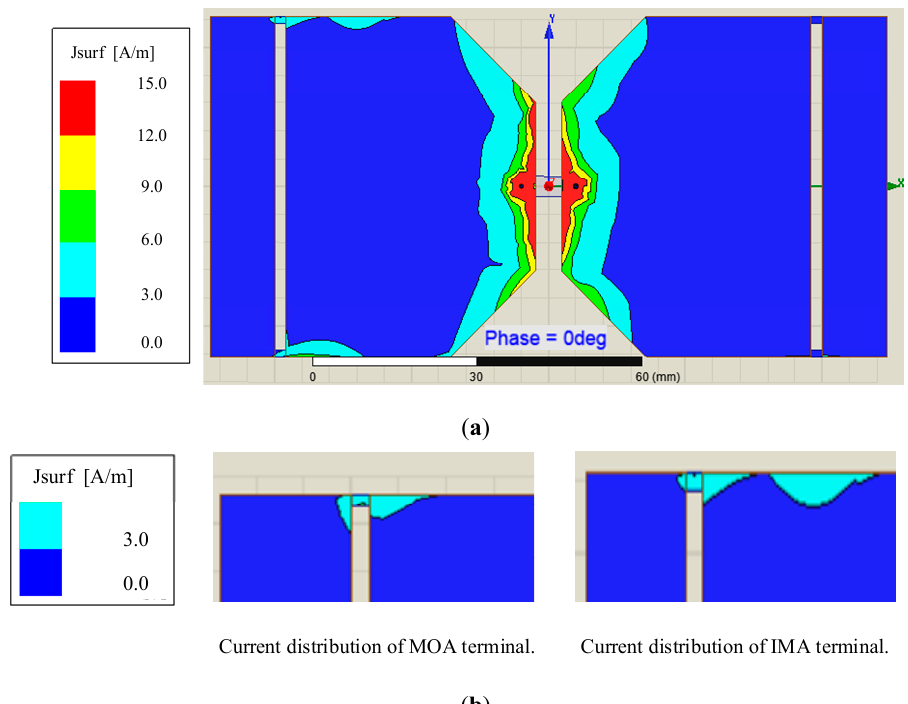
Figure 13. ( a ) Current distribution of the IMA; ( b ) Comparison of current distribution between two